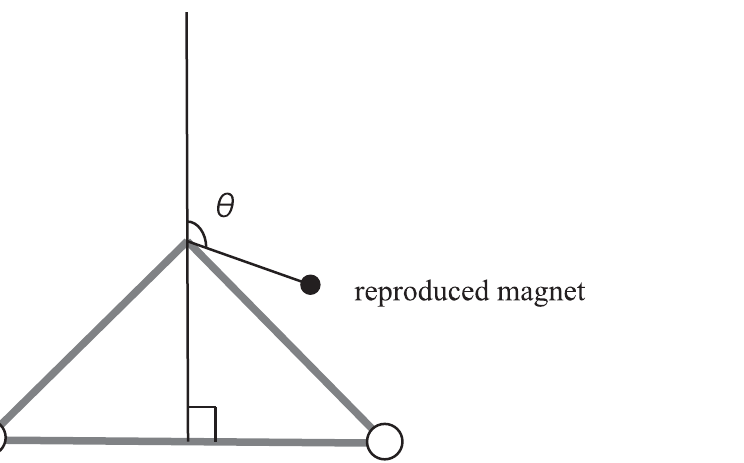
Fig 4. Schematic diagram of the measured angle of the reproduced magnet with respect to the accurate position. The top right area depicts angular deviations in the range of 0 to 90 degrees, bottom right area depicts angular deviations in the range of 90 to 180 degrees (a rightward rotational deviation), the bottom left area depicts angular deviations in the range of 180 to 270 degrees (a leftward rotational deviation), and the top left area depicts angular deviations in the range of 270 to 360